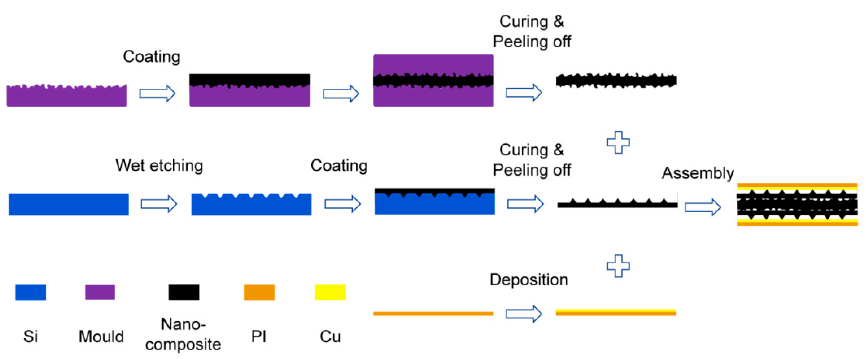
Figure 5. Fabrication process of the piezoresistive tactile sensor.